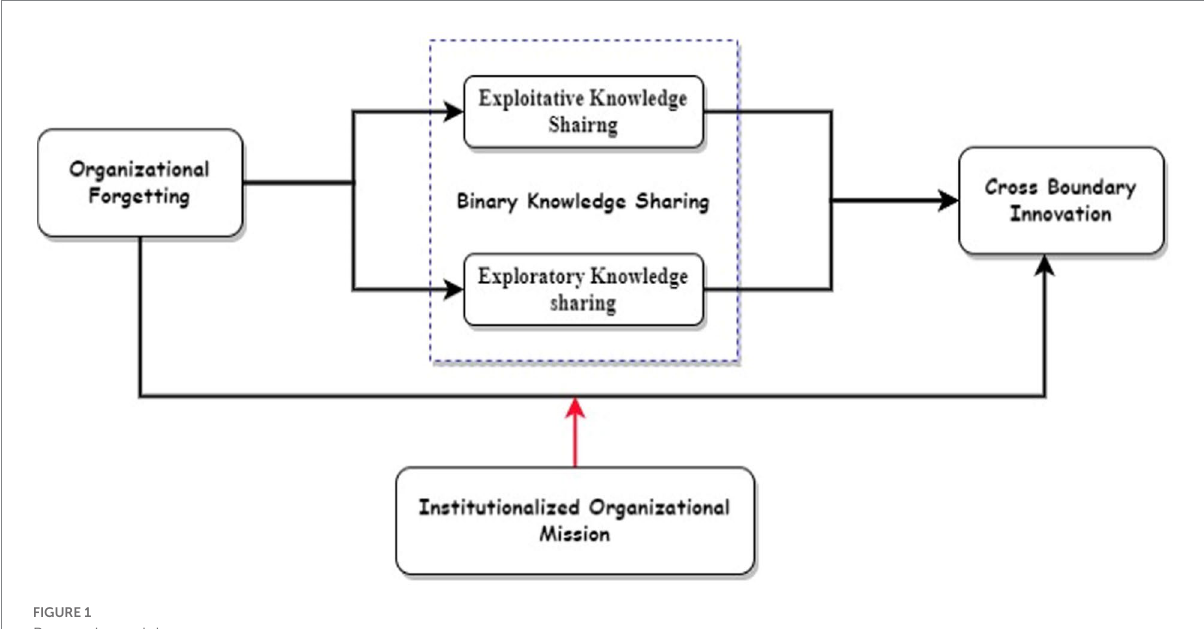
FIGURE 1 Research